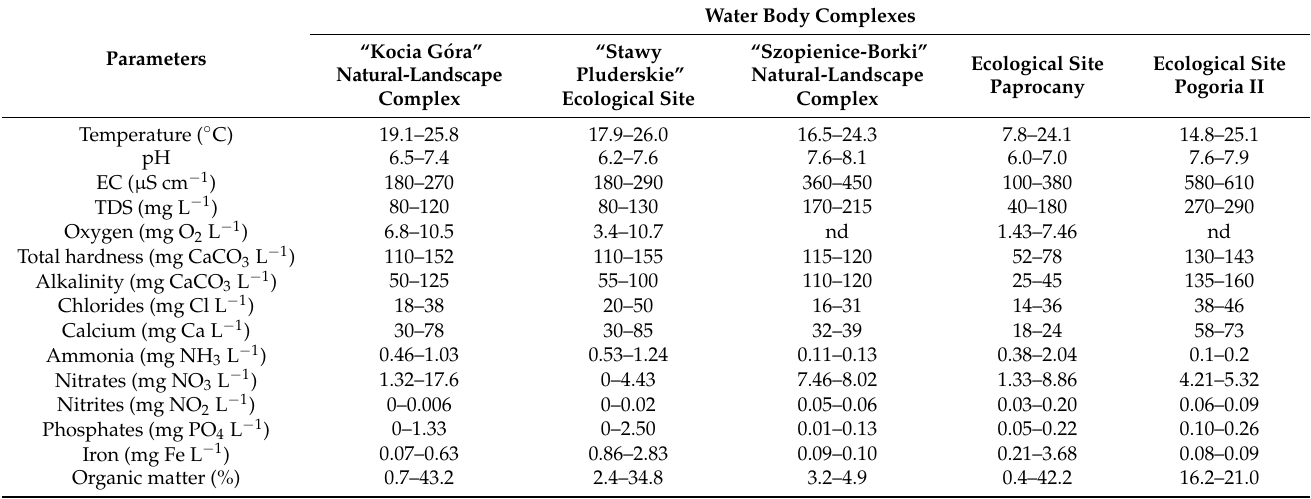
Table 2. The parameters of water and organic matter content in the bottom sediments of water bodies covered with different types of habitat protection (ranges); nd—no